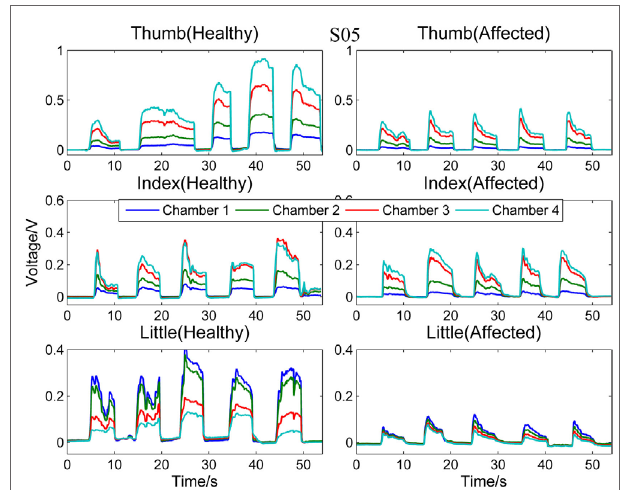
FigUre 4 | comparison between healthy and affected hands of s05 . Signals recorded from the four chambers of the finger sensor when three different types of finger actions were performed by S05, namely compressing the sensor body with thumb, index finger, and little finger, respectively.